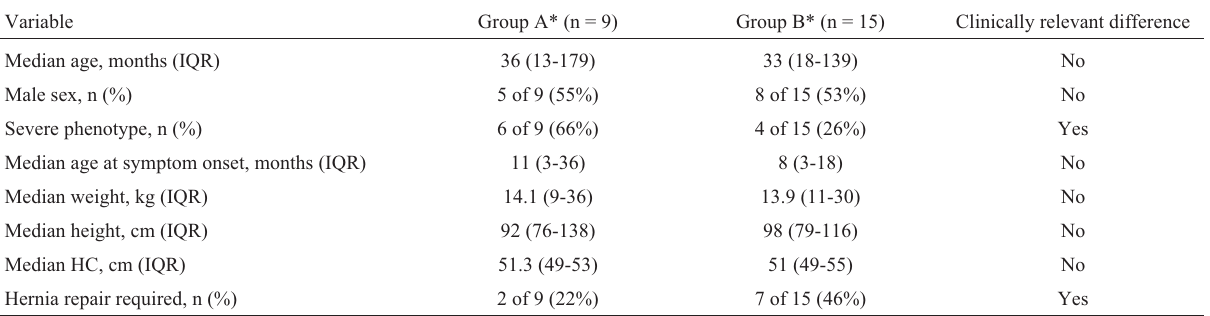
Table 2 - Comparison between Groups A and B at T1 (diagnosis) (n =